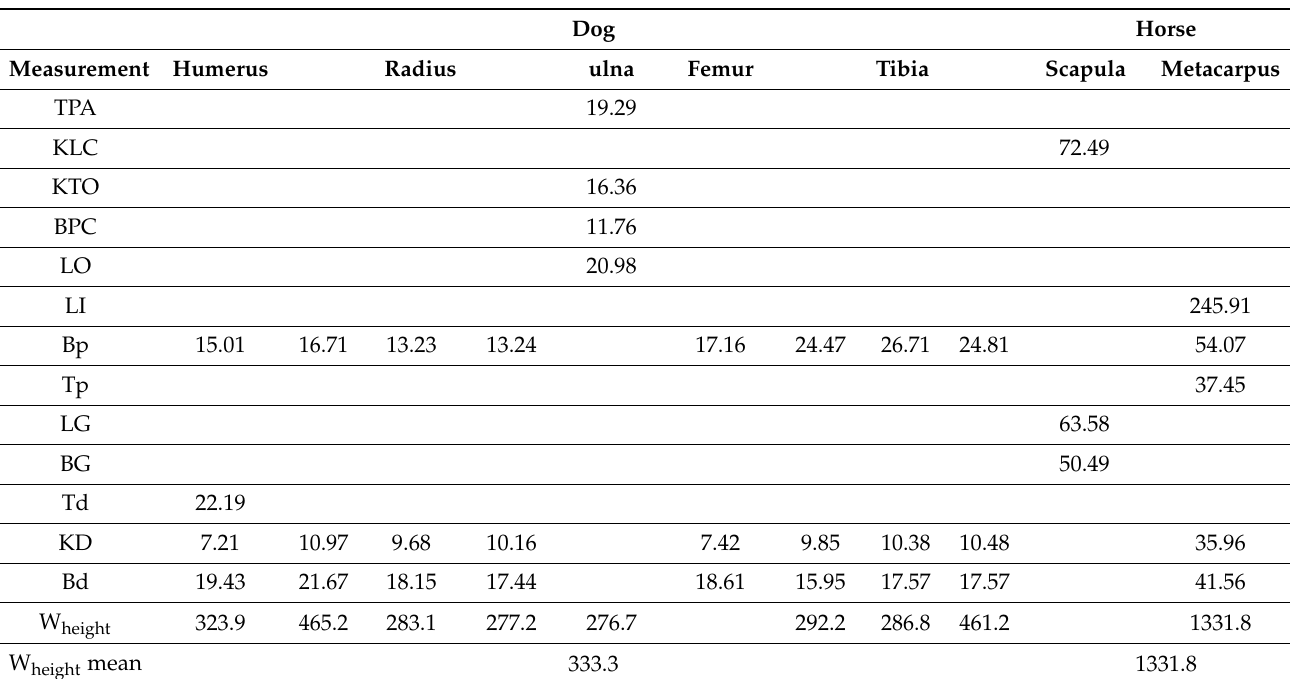
Table 5. The osteometry of measurable horse’s bone remains from Złotoryja with computed height at withers [mm].